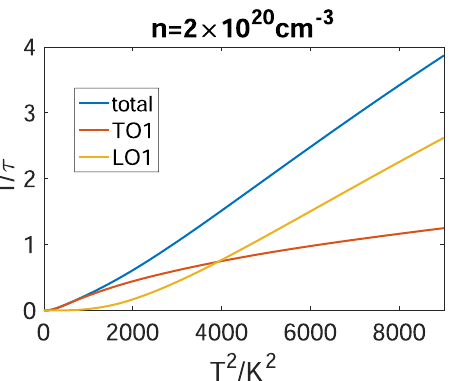
Fig. 3 T 2 scattering rate. (Blue) Scattering rate as a function of T 2 . Contributions from TO1 (Red) and LO1 (yellow) phonons are included. Parameters ω T = 6 meV, ω L = 20 meV 6 , A T = 1 and A L = 15 are taken. Blue line is the sum of the red (TO1 contribution) and yellow (LO1 contribution)